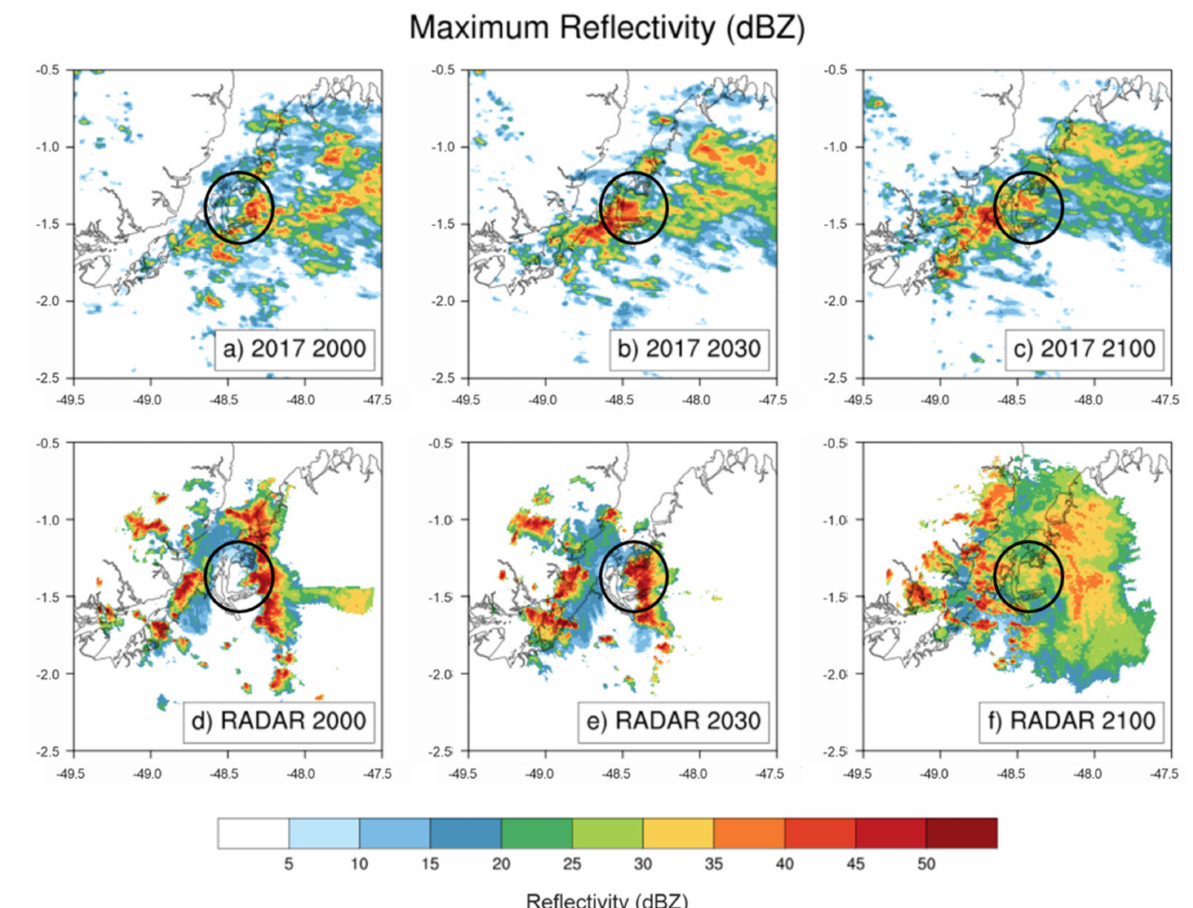
Figure 6. WRF ( a – c ) and radar ( d – f ) maximum reflectivities observed through the entire model height (dBZ) for three periods: 2000 ( a , d ), 2030 ( b , e ), and 2100 UTC ( c , f ) on 7 June 2011. The black circle marks the BMR